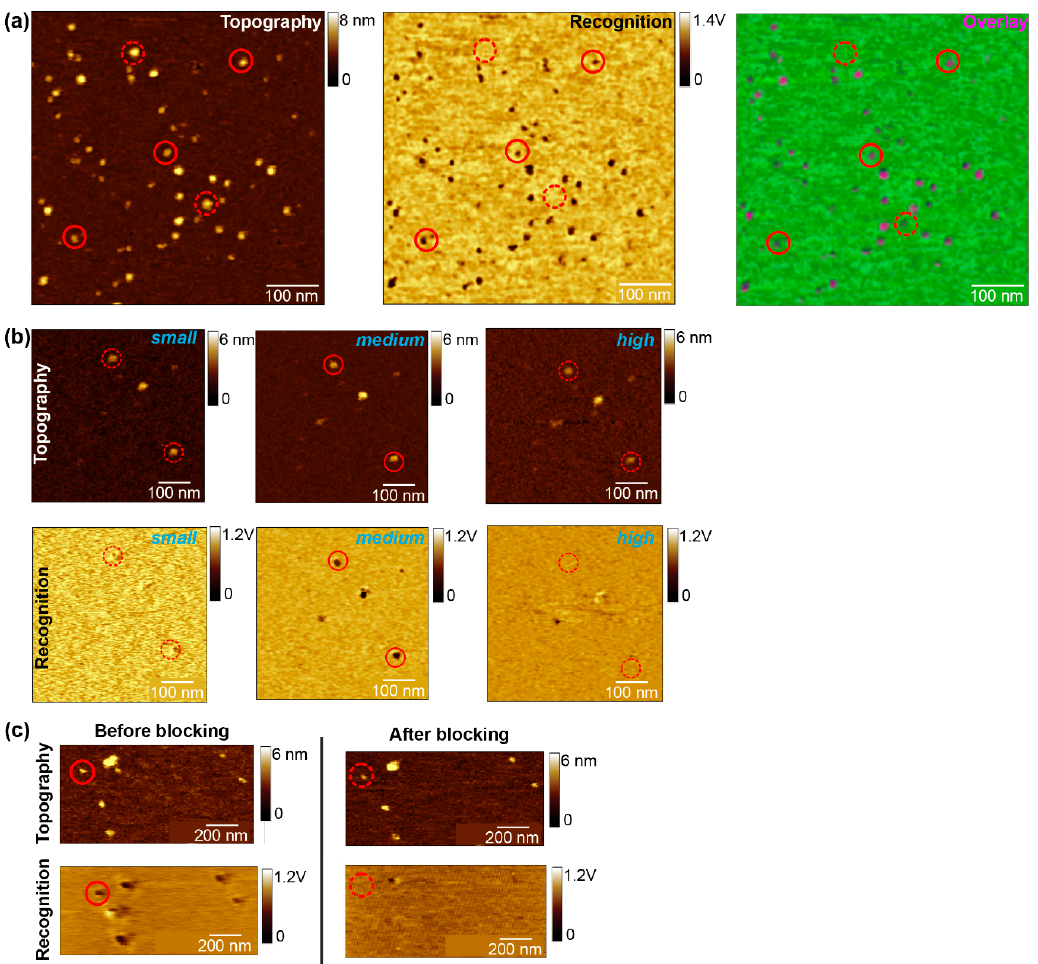
Figure 2. Proof of concept: quantitative characterization of the binding mechanism between Uncoupling Protein 1 (UCP1) and its inhibitor adenosine triphosphate (ATP) (adapted from